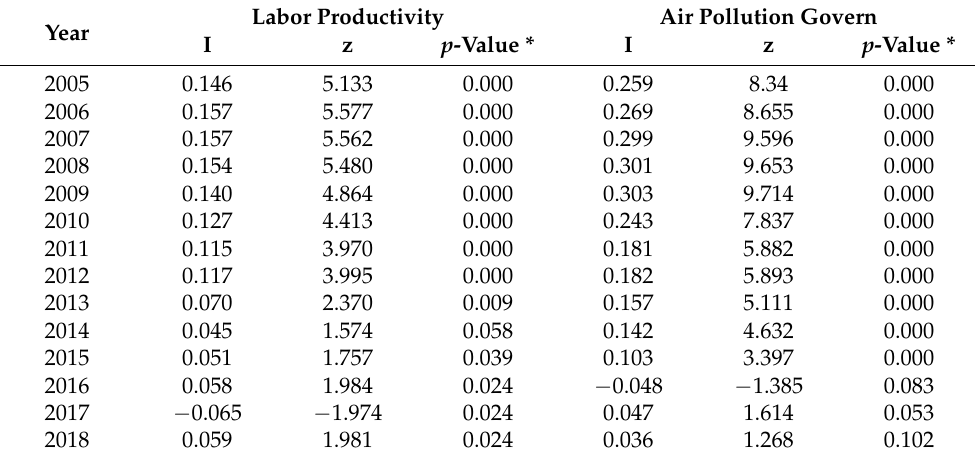
Table 2. Air pollution governance and labor productivity: Moran’s index.